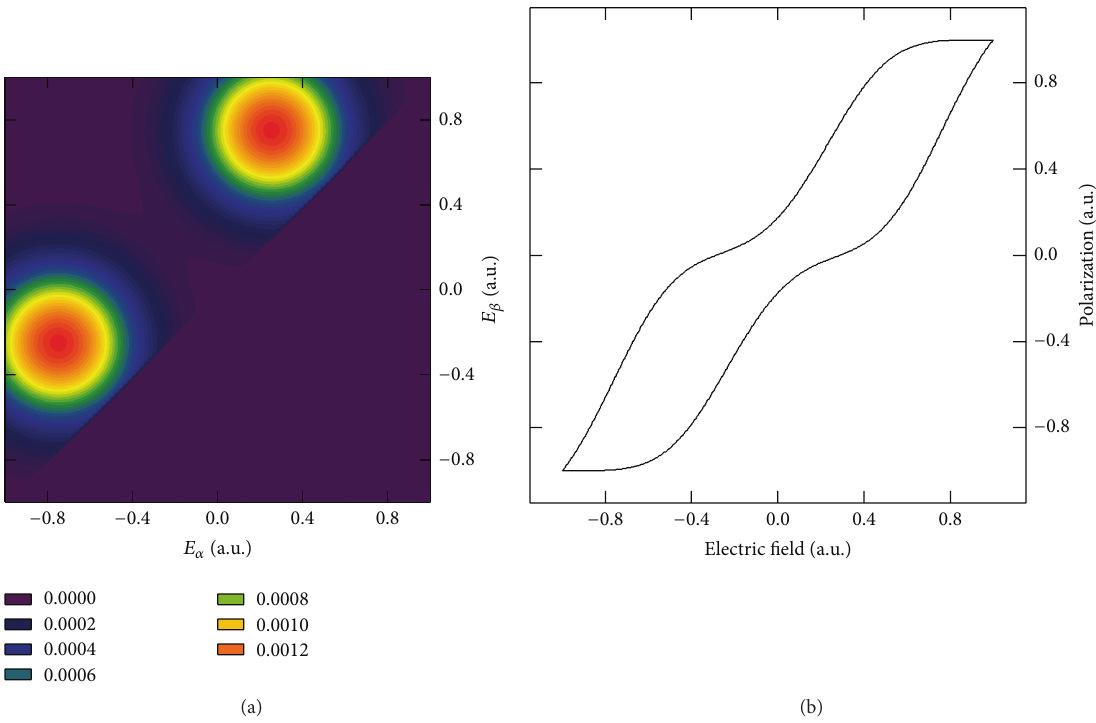
Figure 7: (a) Illustrations of two separate Preisach density peaks and (b) the associated pinched hysteresis